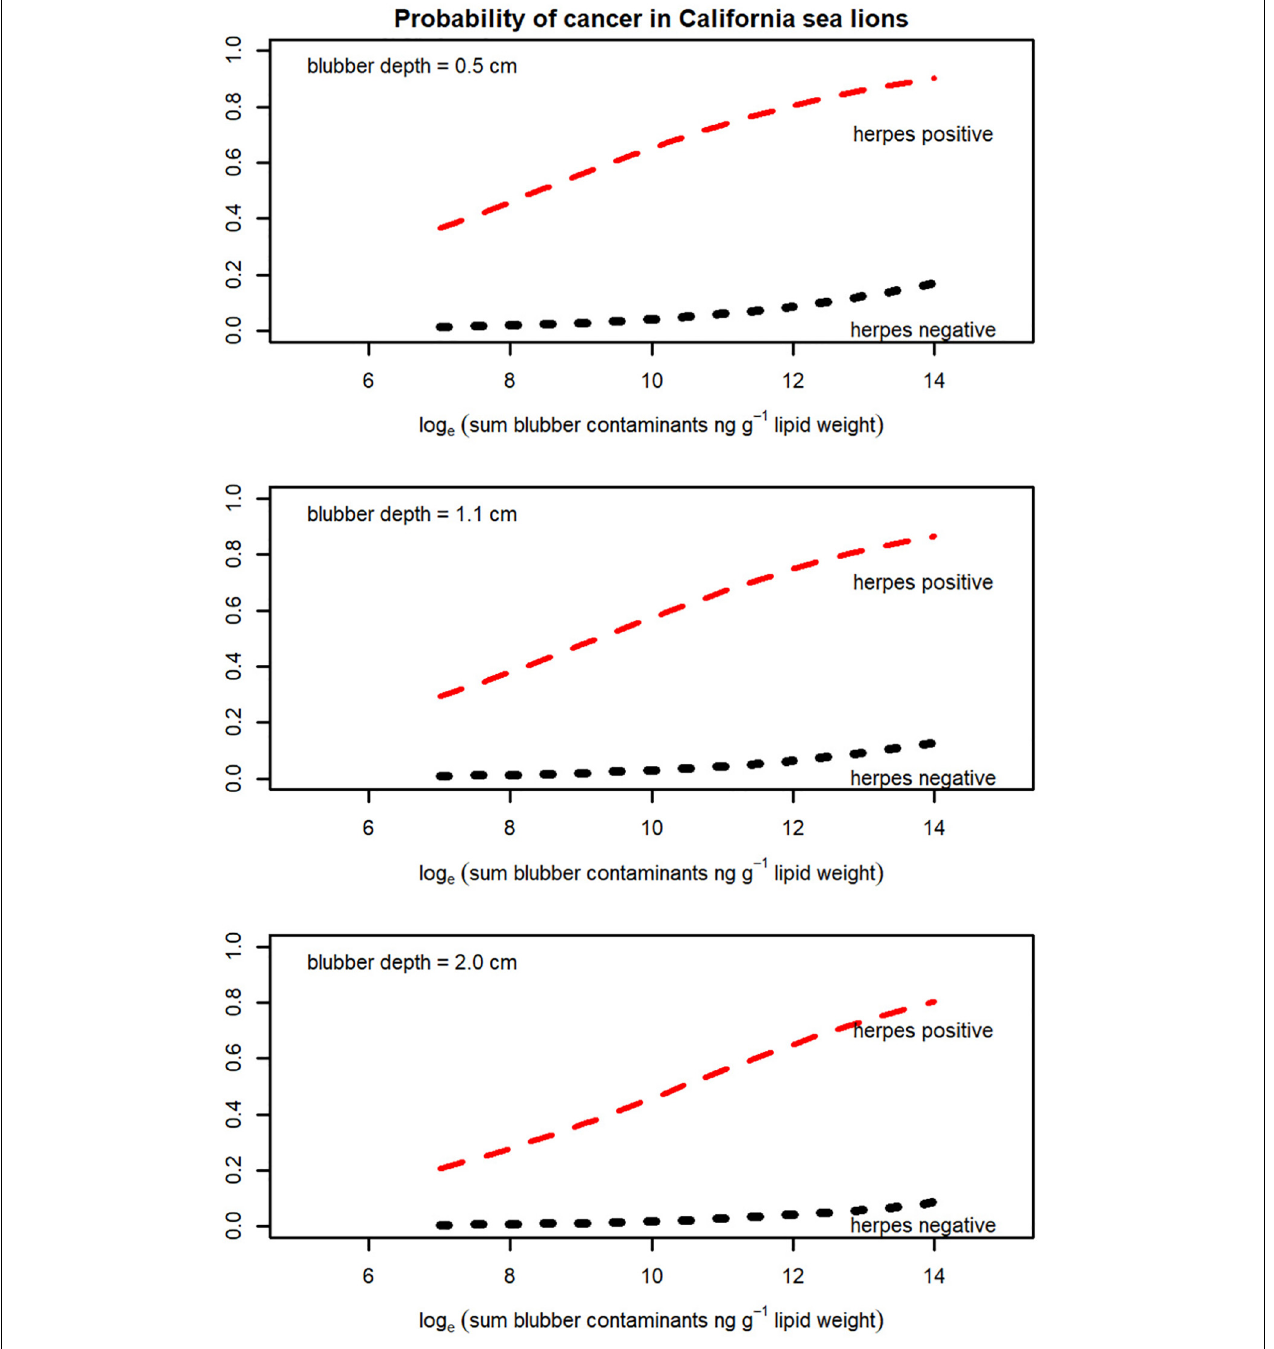
FIGURE 4 | Probability of cancer in California sea lions with increasing blubber contaminant concentrations for animals with thin blubber (0.5 cm), the mean blubber thickness for the study group (1.1 cm) and with thick blubber (2.0 cm). Red = animals with herpesvirus; Black = animals without herpesvirus.